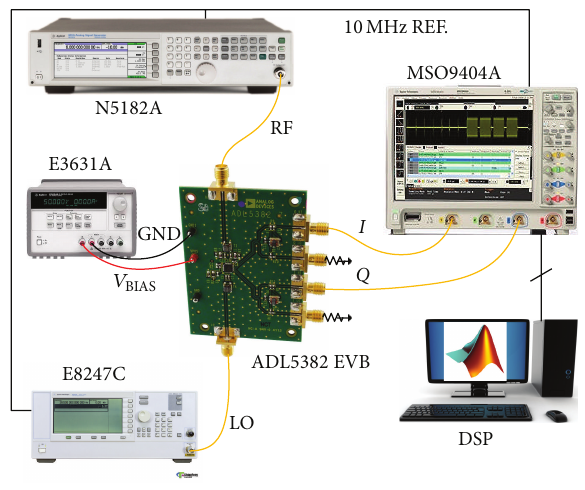
Figure 5: Test setup for the low-IF receiver.